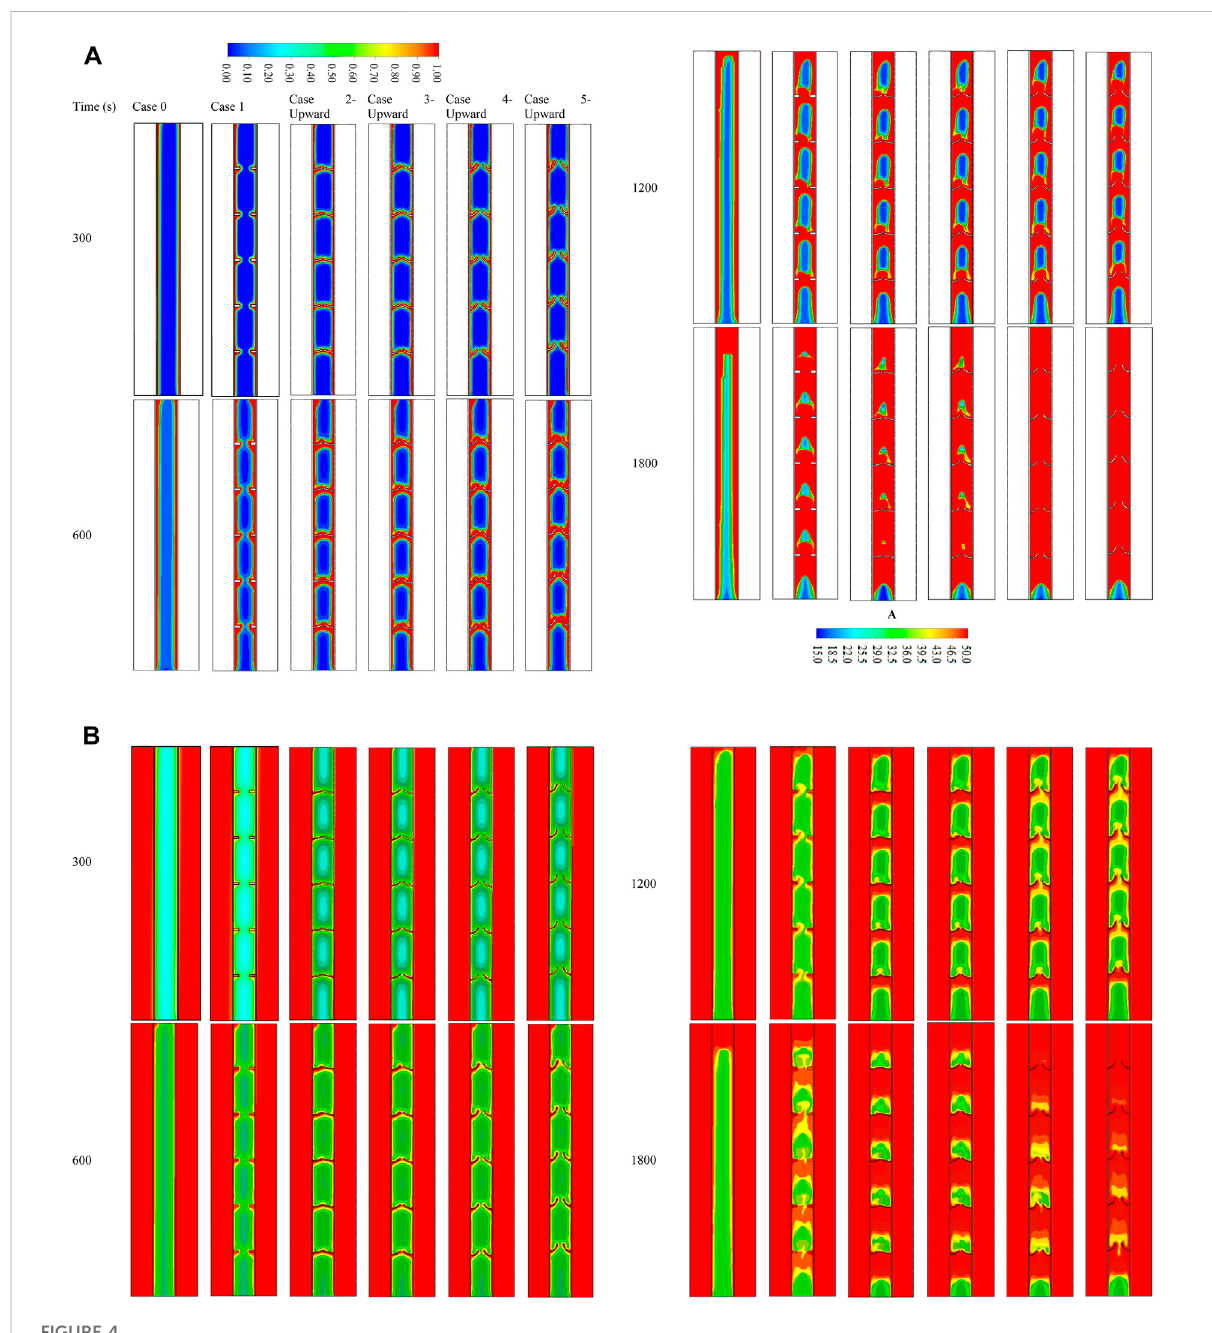
FIGURE 4 (A) Liquid fraction and (B) temperature development for various cases at different time steps (up to 1,800